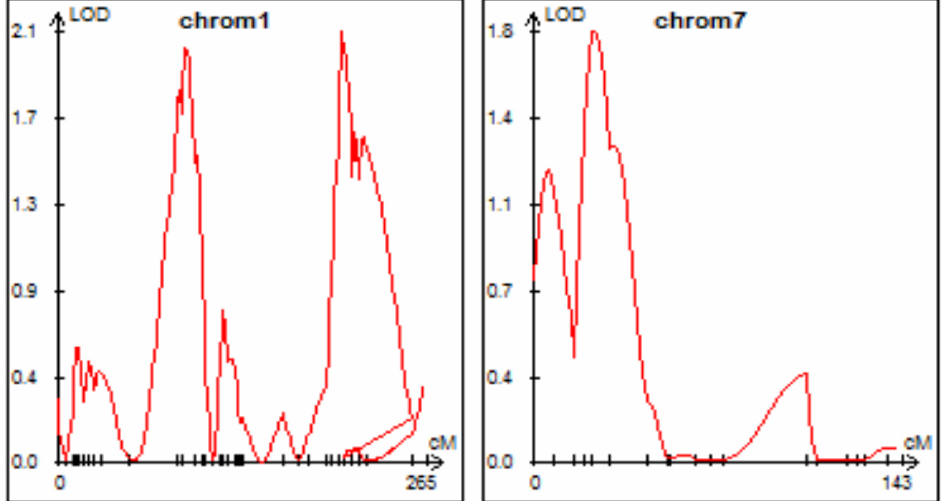
Fig 2. Five QTLs detected by MIM for grain yield on rice chromosome 1 and 7 under E2